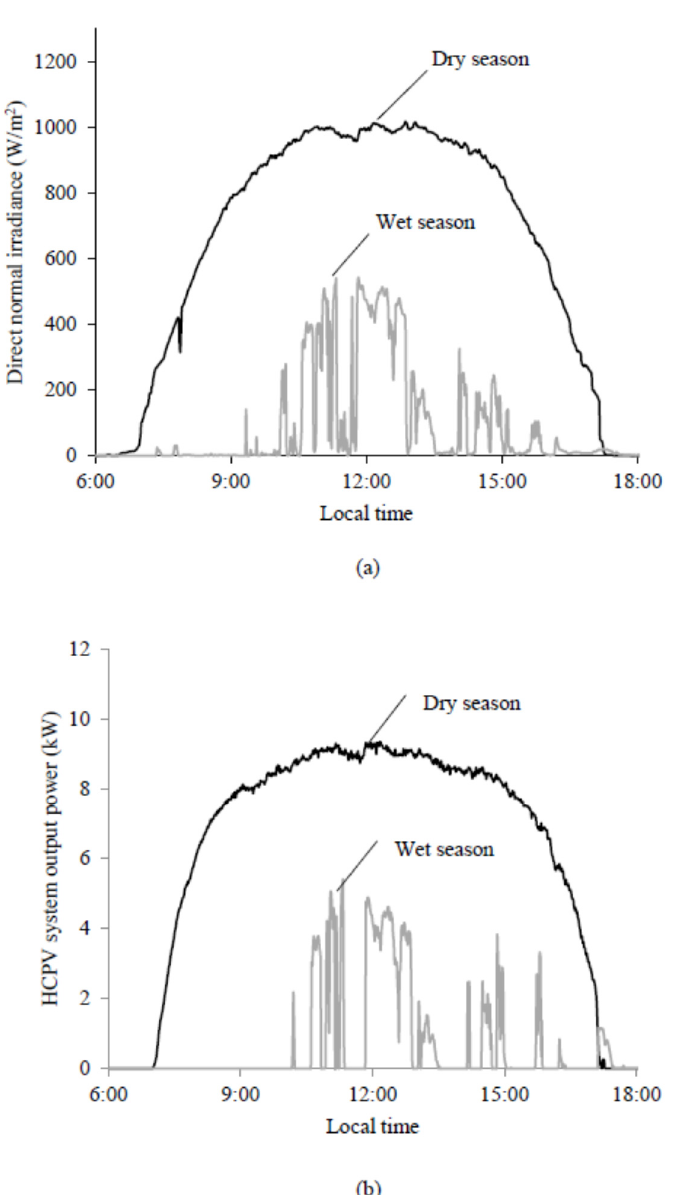
Figure A1. Dependance of HCPV output power on the direct normal irradiance in typical days of the dry season (21 February 2015) and wet season (6 June 2014): ( a ) Direct normal irradiance; ( b ) HCPV system output power.